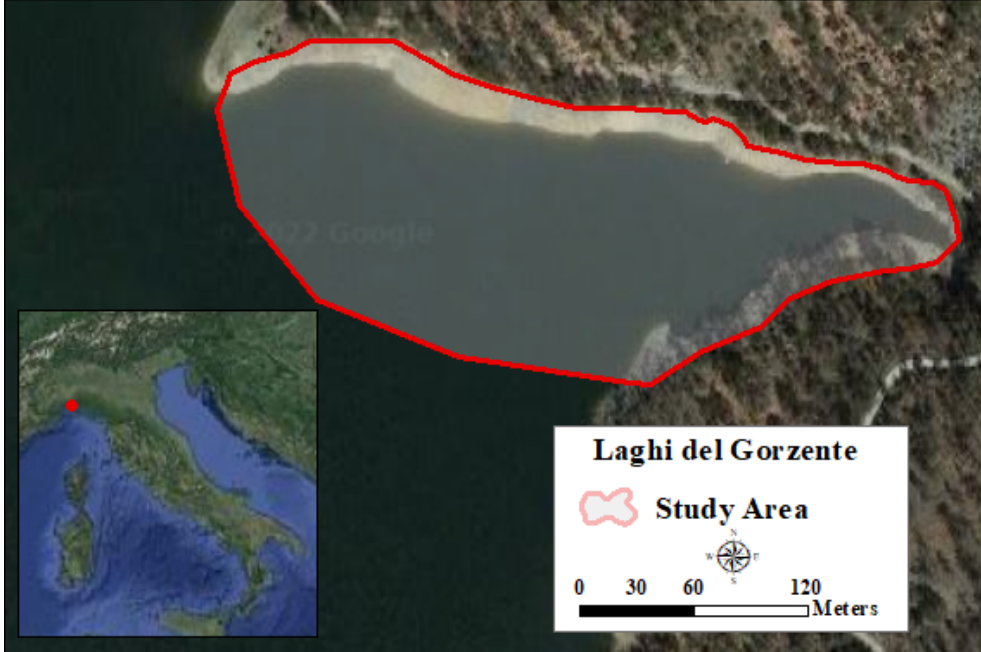
Figure 2. Study area targeted (emerged and submerged zones) over Laghi del